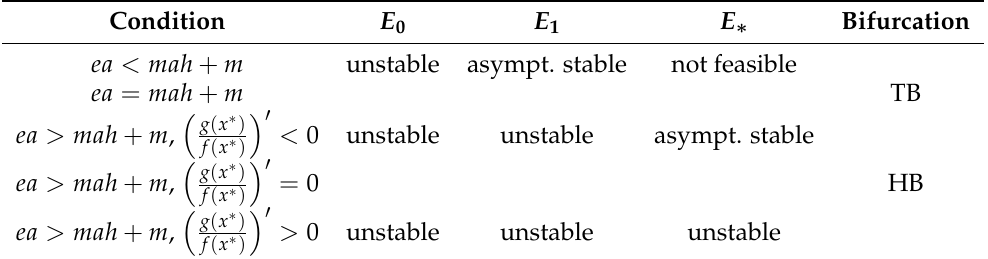
Table 4. Conditions for feasibility and stability of the equilibria of the system in (37) and (38). TB: transcritical bifurcation. HB: Hopf